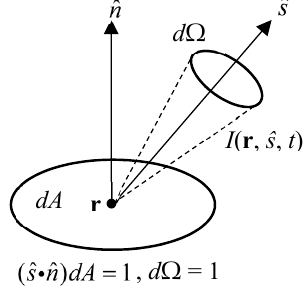
Figure 1. Definition of the radiance.